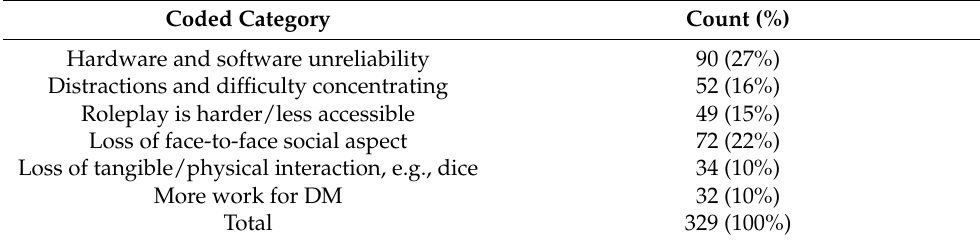
Table 2. Negative Experiences in Transitioning to Remote